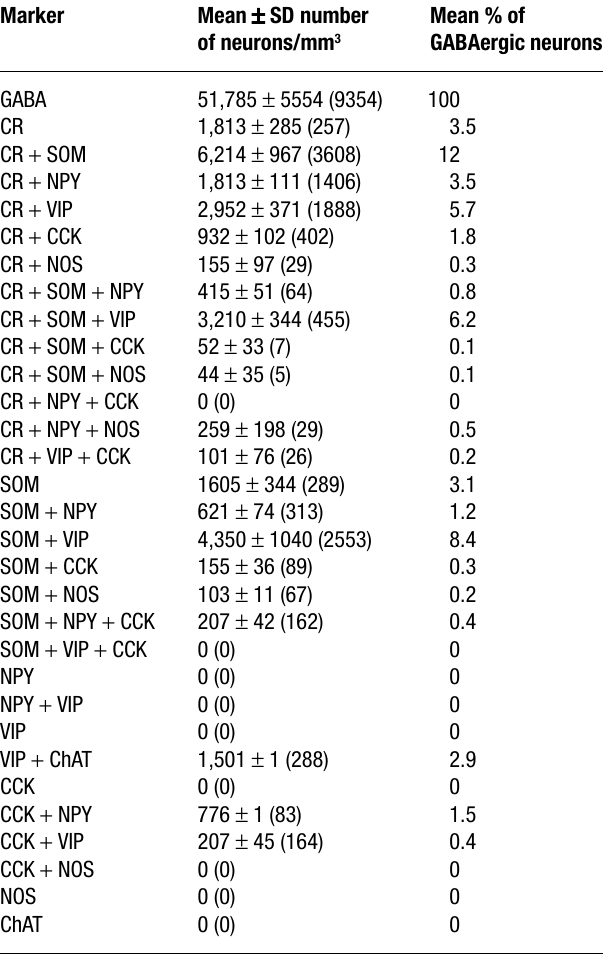
Table 3. Percentage of interneurons that express different combinations of CR, SOM, VIP, NPY, CCK, NOS and ChAT in the total population of GABAergic neurons in adult mouse visual cortex. The counts were made in triple labeled sections by using systematic random sampling of labeled neurons with the optical disector probe. CR and SOM represent neurons that express no additional substances. The total number of cells counted is shown in